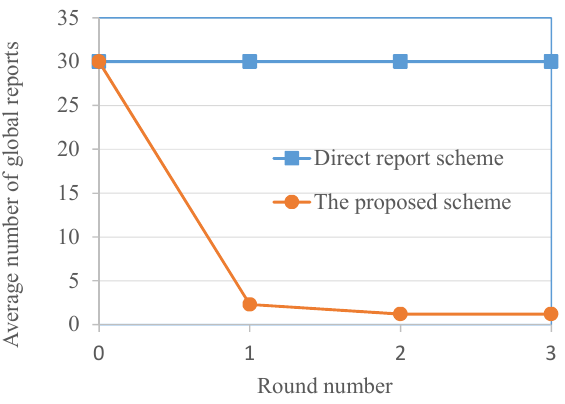
Figure 15. Average report number in Scenario